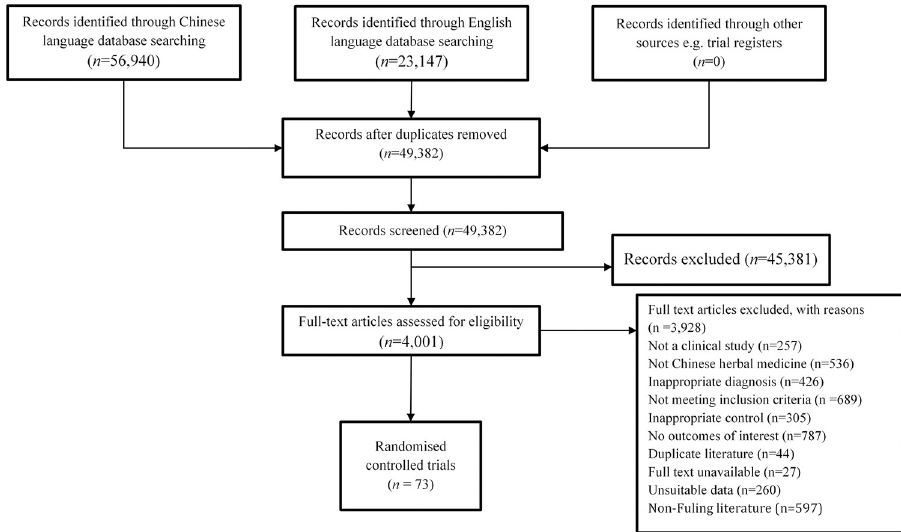
Fig 1. Flow chart of study selection